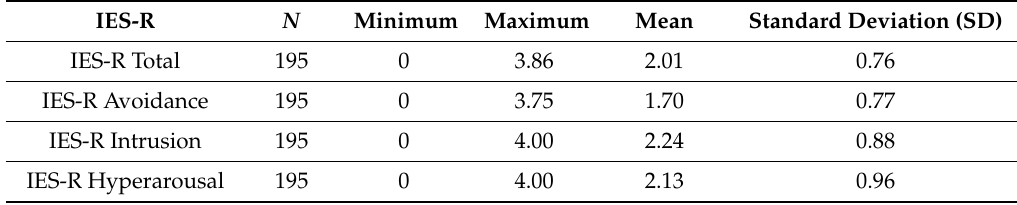
Table 2. Impact of Event Scale-Revised (IES-R) and individual subscale